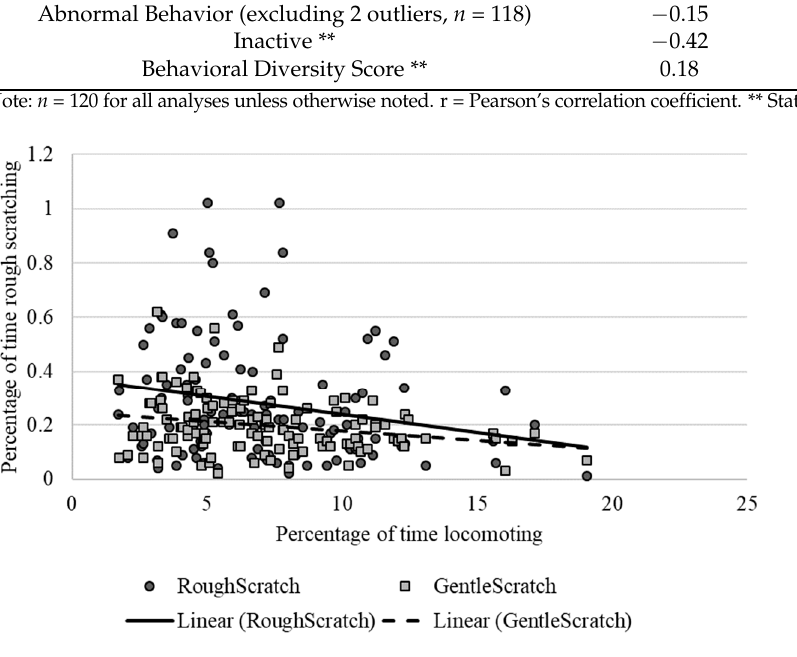
Figure 6. Negative relationship between the mean percentage of time spent locomoting and the percentage of time spent rough scratching (dark circles and solid trend line) and gentle scratching (light squares and dotted trendline). Chimpanzees that exhibited higher levels of scratching showed lower levels of locomotion.